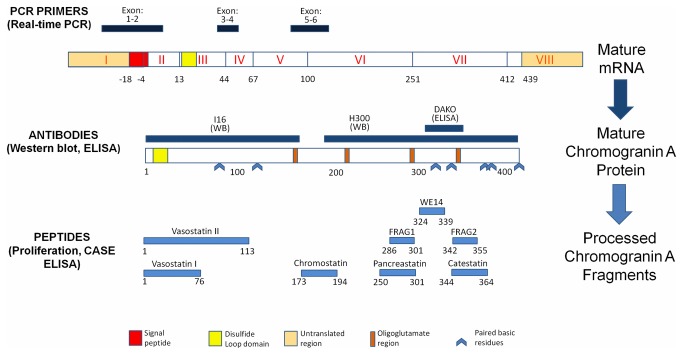
CgA coding regions, putative functional domains and targets.The primary transcript, on chromosome 14, is derived from 8 exons and includes exon 1 which is untranslated but contains a signal peptide region for protein processing. In this study, PCR was performed using intron spanning primers to examine exons I-VI. Mature CgA mRNA includes 439 coding base pairs which are translated into a primary peptide of 431 amino acids. Processing of CgA following cleavage at dibasic and monobasic residues e.g. by PC1/3 and CPE results in production of a range of intermediate peptides as well biologically active peptides [36].